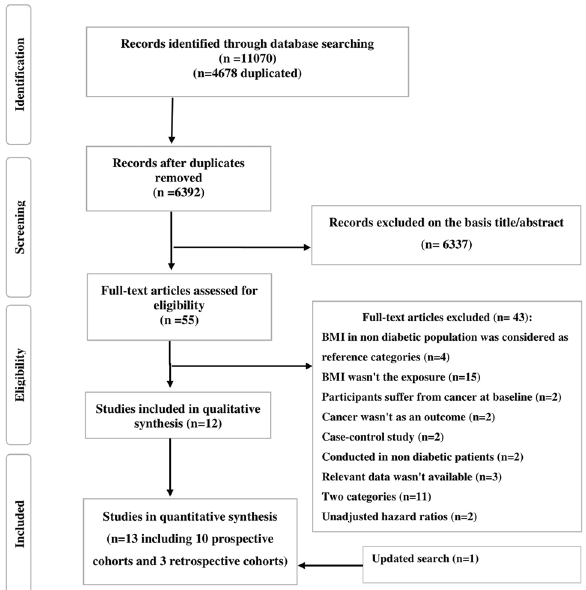
Figure 1. Flow diagram of the study selection